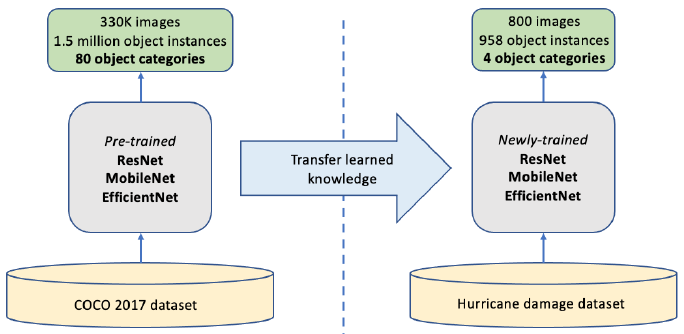
Figure 2. The transfer learning workflow for object detection of four object categories by using pre-trained ResNet, MobileNet, and